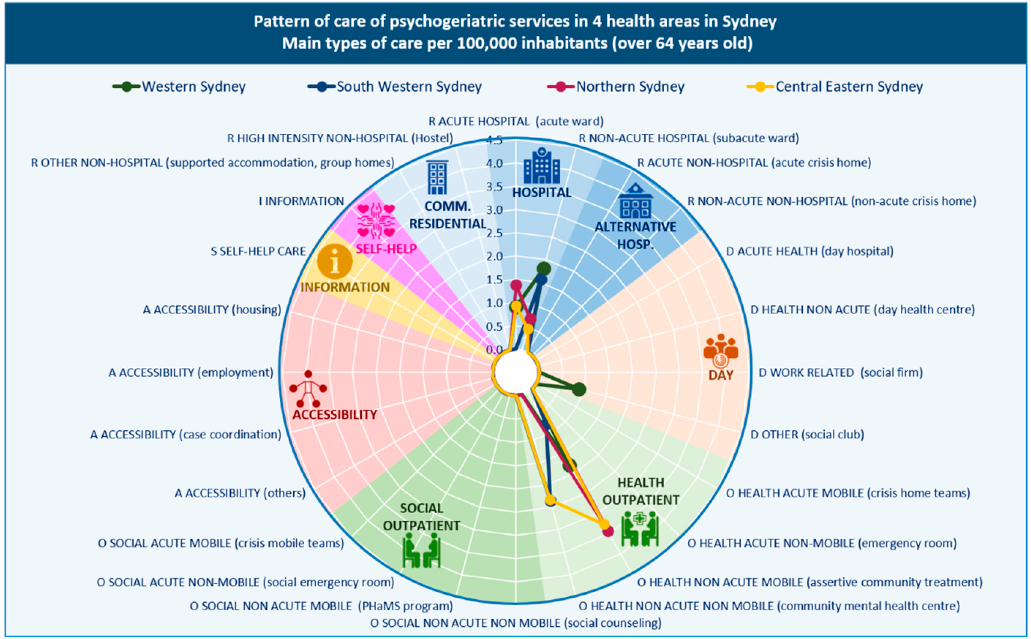
Figure 2. Pattern of care of mental health services in Sydney health districts: main types of care per 100,000 inhabitants aged 65 years and over.